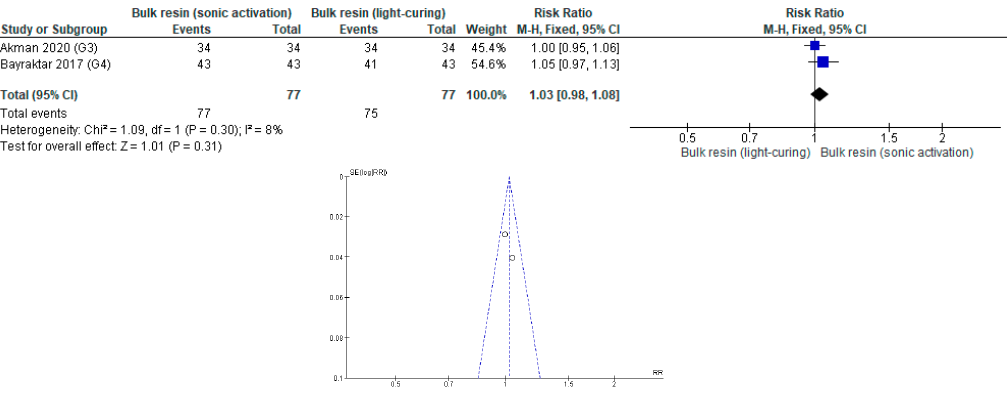
Figure A24. Absence of Secondary Caries: Conventional Resin versus Bulk Resin According to the Technique Used.